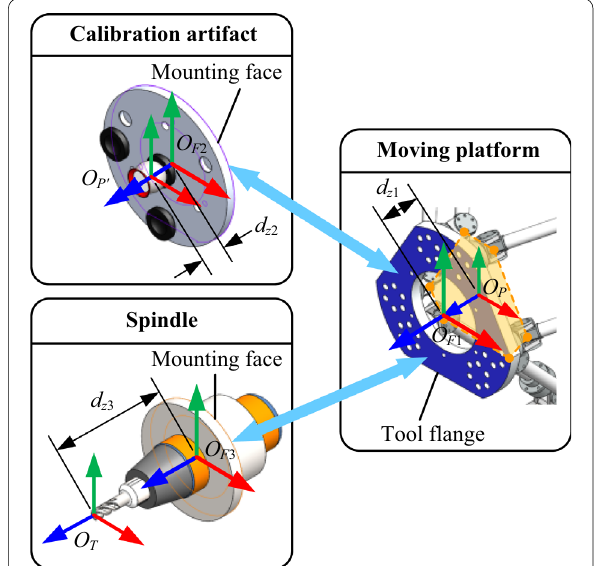
Figure 6 Relative positions of the calibration artifact, spindle, and moving